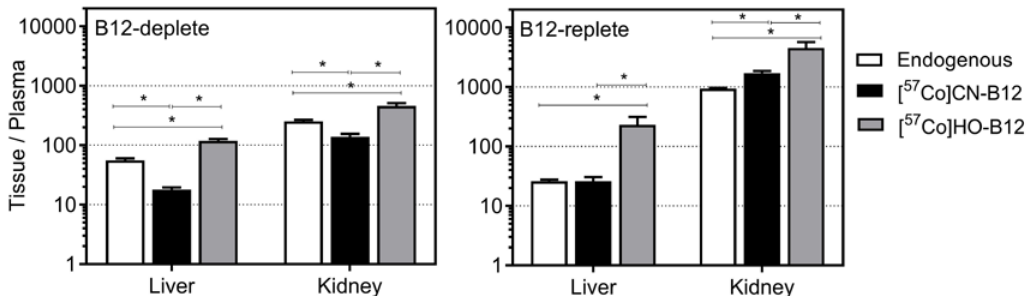
Figure 3. Ratios of endogenous B12 and [ 57 Co]B12 in kidney and liver. Ratios (mean tissue B12/mean plasma B12) of endogenous B12 (pmol/g)/(pmol/ml) (white bars, n = 16 B12-deplete, n = 12 B12-replete) and [ 57 Co]B12 (cpm/g)/(cpm/mL) accumulated one week after administration of oral [ 57 Co]CN–B12 (black bars, n = 8 B12-deplete, n = 6 B12-replete) and [ 57 Co]HO–B12 (grey bars, n = 8 B12-deplete, n = 6 B12-replete) in rats kept on a diet with low-B12 or high-B12 for 17 days. The ratios (bars) are shown as mean ± SEM. X-axis indicates the tissues examined (liver and kidney). Y-axis indicates tissue/plasma ratio on a log-scale. Dashed horizontal lines are depicted to simplify comparison of bars. Differences between adjacent bars were determined by the unpaired t -test. p -values ≤ 0.05 were judged as statistically significant and are indicated by asterisks.